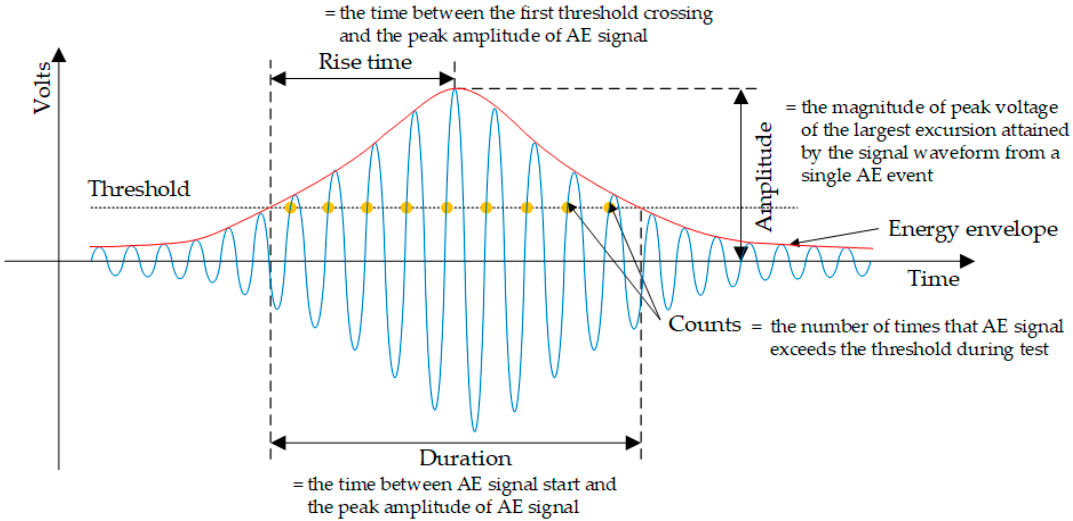
Figure 5. Acoustic emission (AE) signal and parameters.